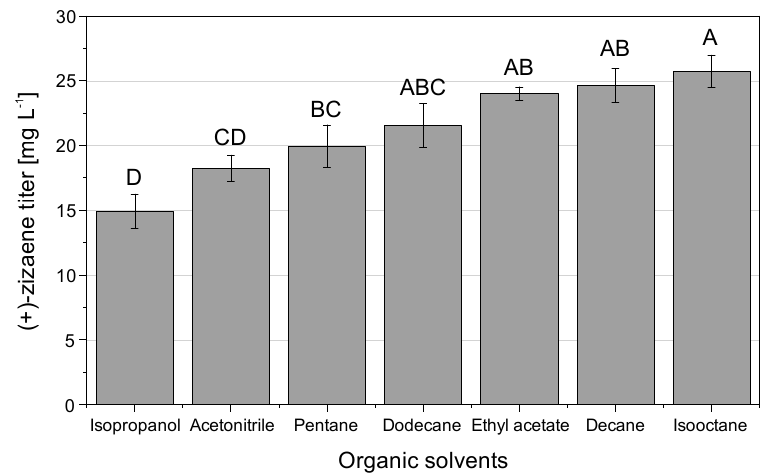
Figure 5. Elution performance of distinct organic solvents for the desorption of (+)-zizaene from the adsorber Diaion HP20. Data correspond to the mean of three independent experiments with error bars as SD. Data analyzed by ANOVA ( α = 0.05), letters that differ are significantly different.